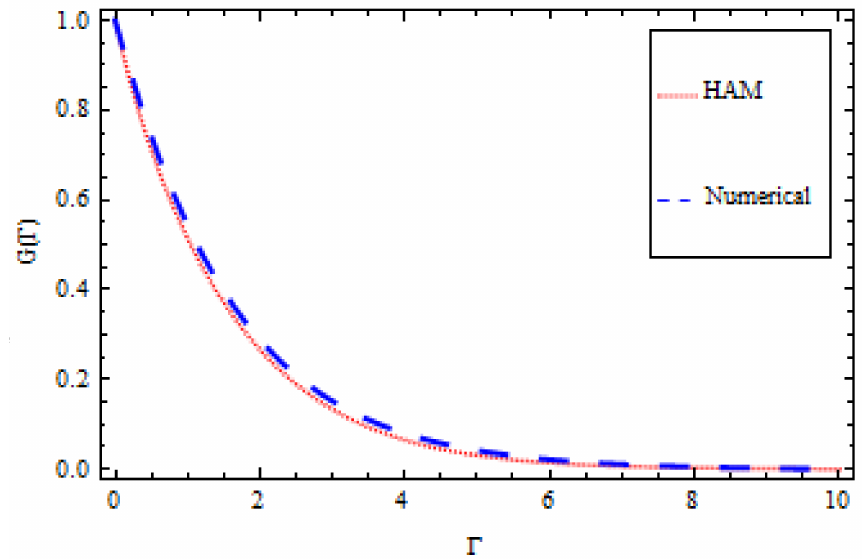
Figure 15. HAM and numerical comparison for temperature profile G ( Γ ) .